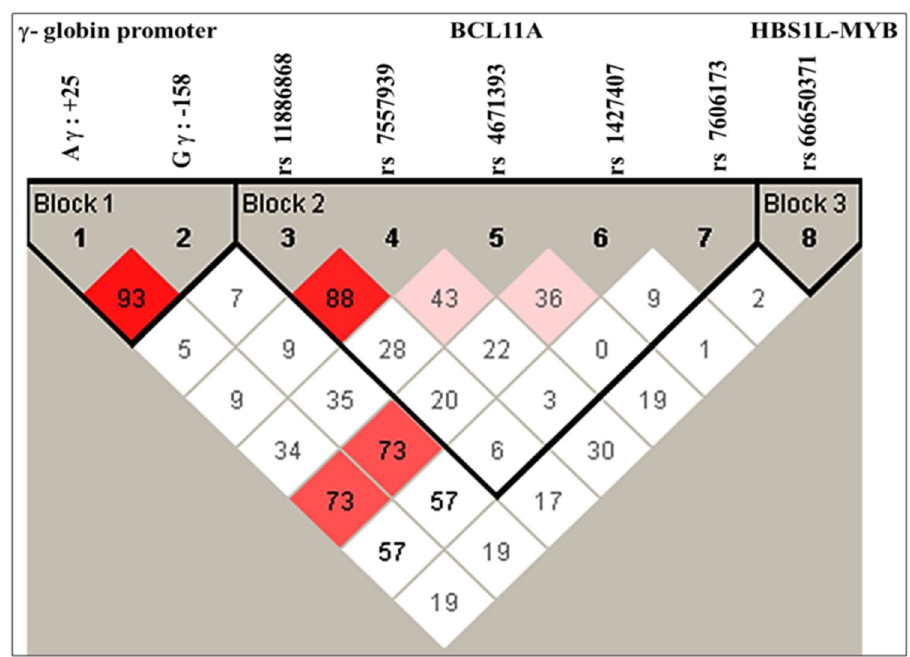
Figure 2. Linkage disequilibrium (LD) plot of the SNPs. It could be observed that the + 25 (G → A) polymorphism in A γ-globin gene and the XmnI polymorphism (− 158 C → T) in the G γ-globin are highly linked (D ′ : 93). Also the SNPs rs11886868 (C → T) and rs7557939 (A → G) in the BCL11A intronic region, are strongly linked (D ′ : 88) with each